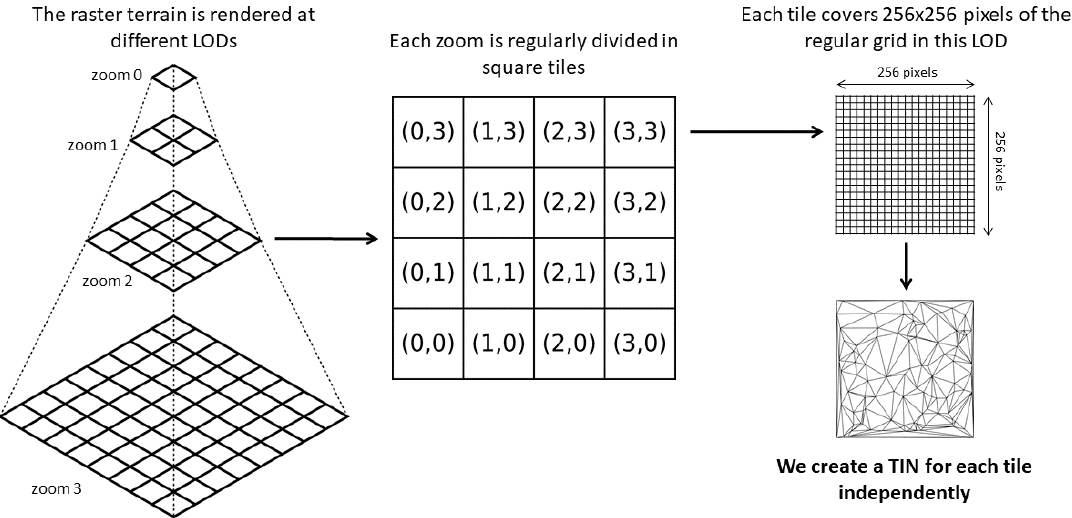
Figure 1. Summary of the method. Level of detail (LOD), triangulated irregular network